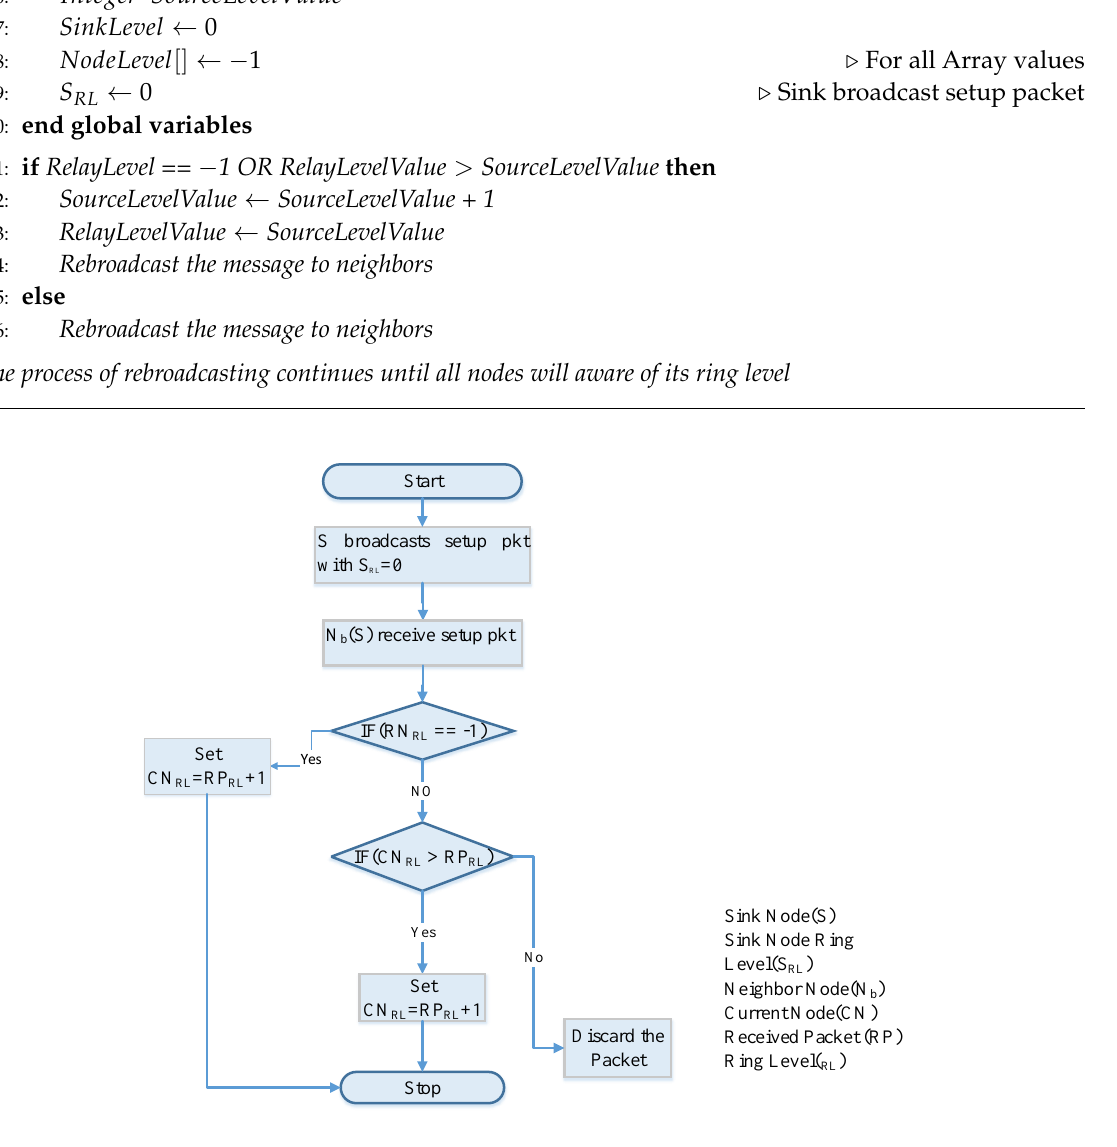
Figure 11. Flow chart of initialization